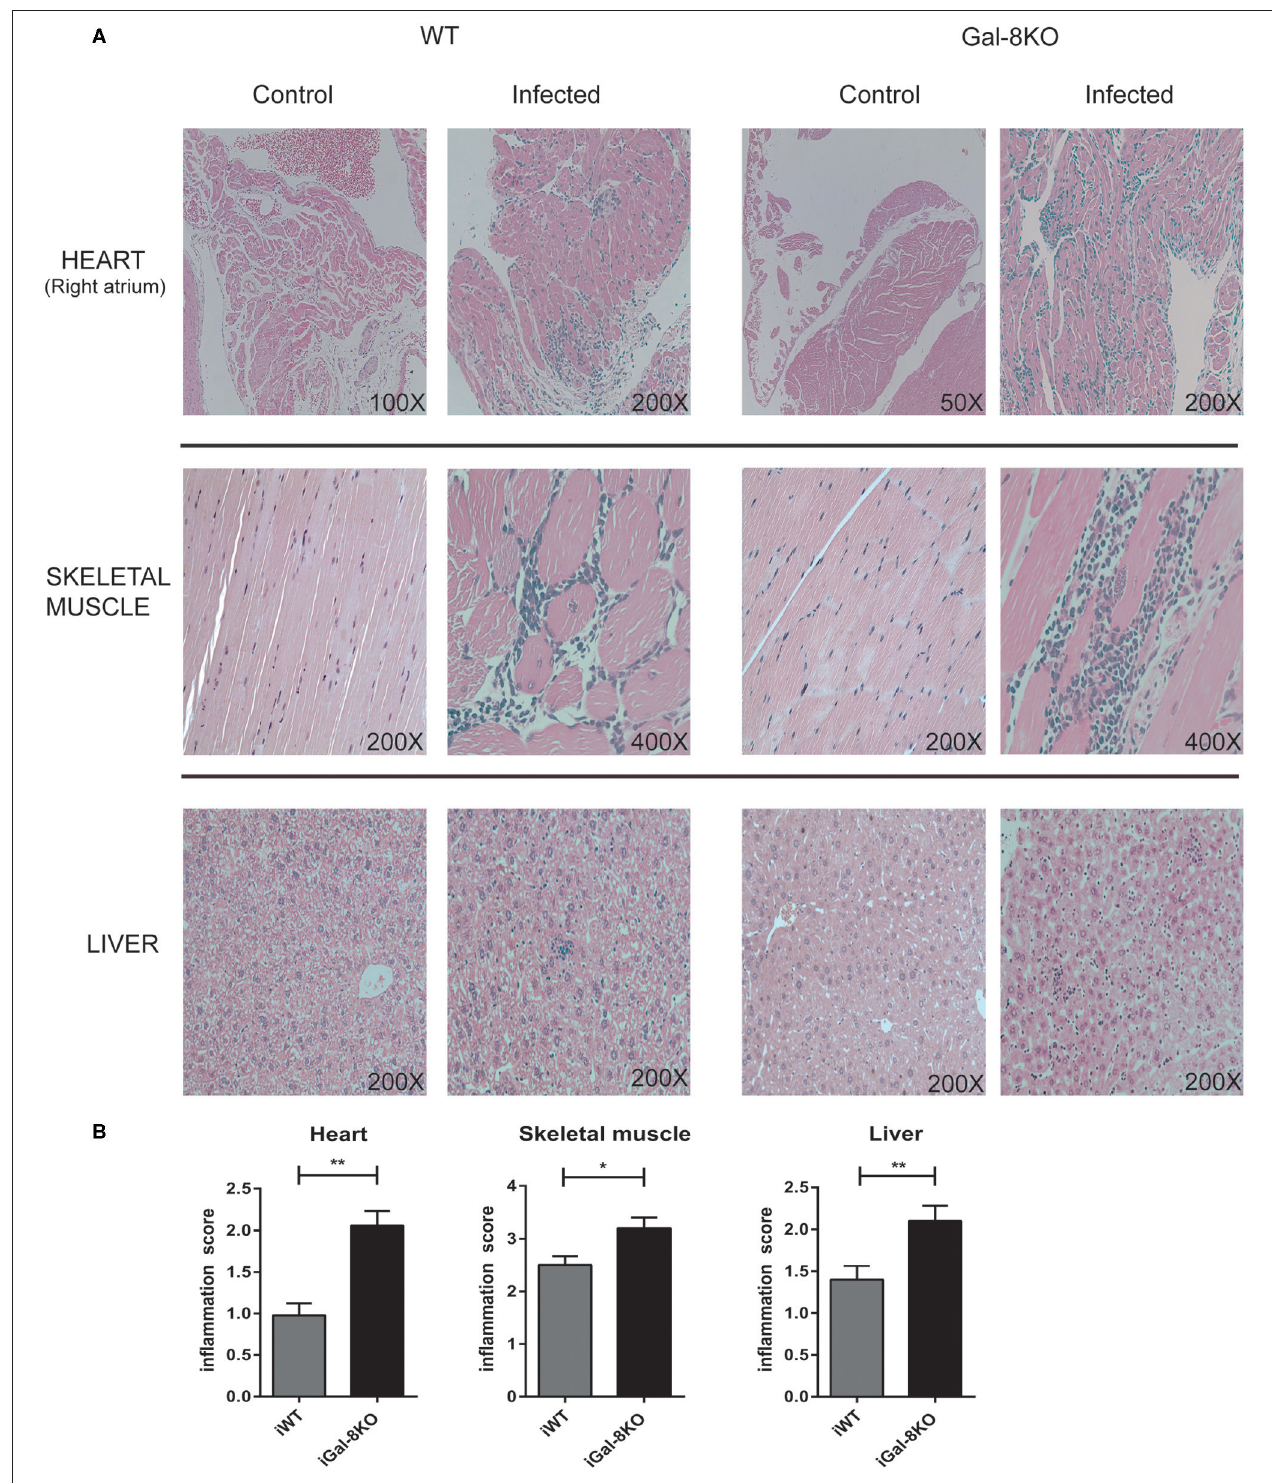
FIGURE 1 | Scoring of tissue inflammation by histopathology. (A) Representative photomicrographs of H&E-stained sections of the heart, skeletal muscle, and liver from Trypanosoma cruzi -infected Gal-8KO, and wild-type (WT) mice and non-infected controls at 4–5 mpi. (B) Scoring of tissue inflammation was estimated as described in Methods section. Data are expressed as mean ± SEM of at least three independent experiments (5 animals/group). * P < 0.05; ** P < 0.01.